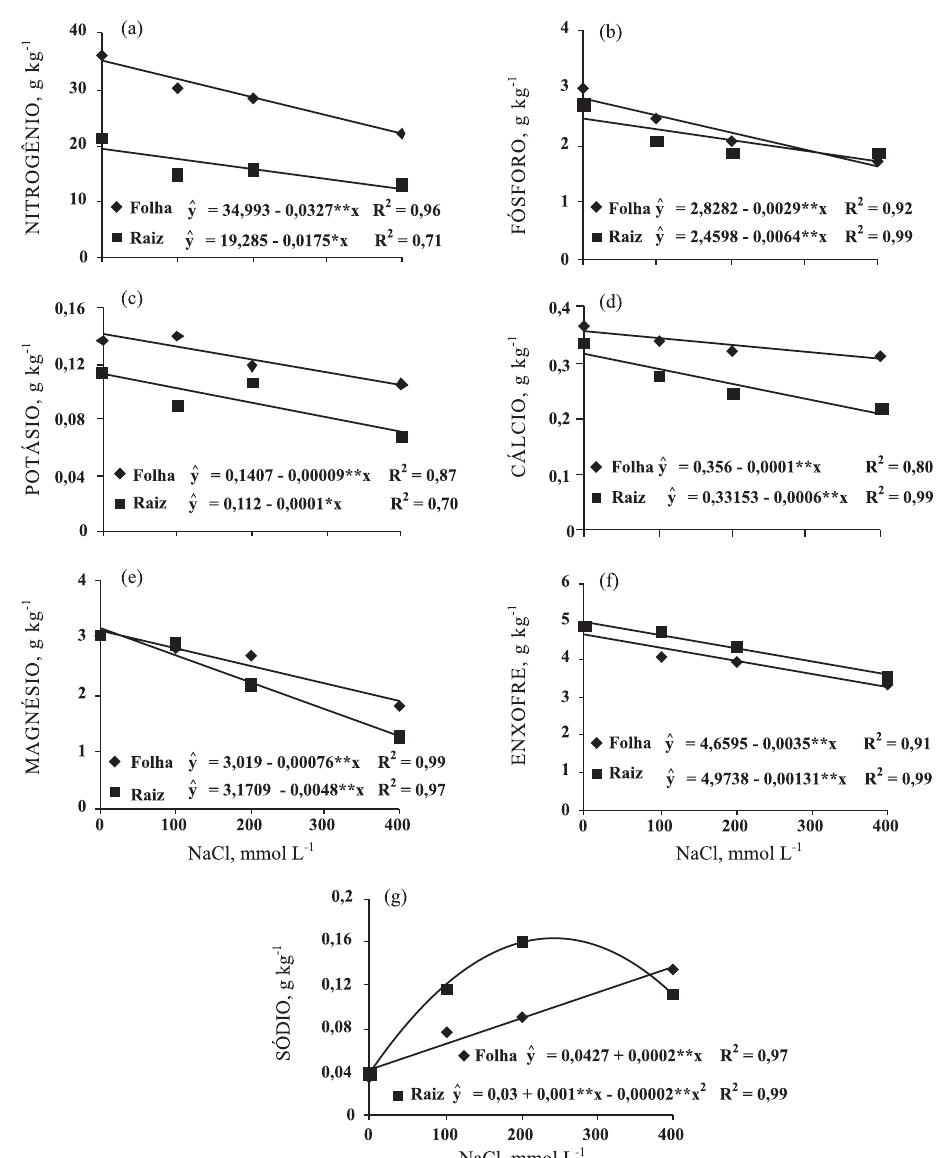
Figura 3. Teores de N, P, K, Ca, Mg, S e Na nas raízes e folhas de mudas de gliricídia em função das concentrações crescentes de NaCl na solução